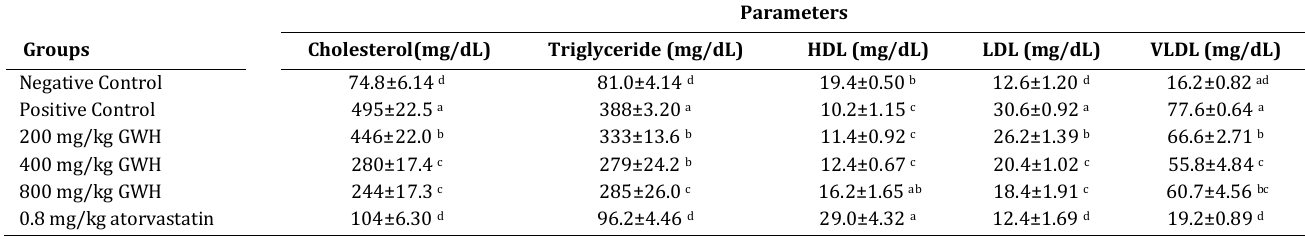
Table 2 . Effect of methanolic extract green walnut husk (GWH) on lipid profiles after 84 days of the experiment 1